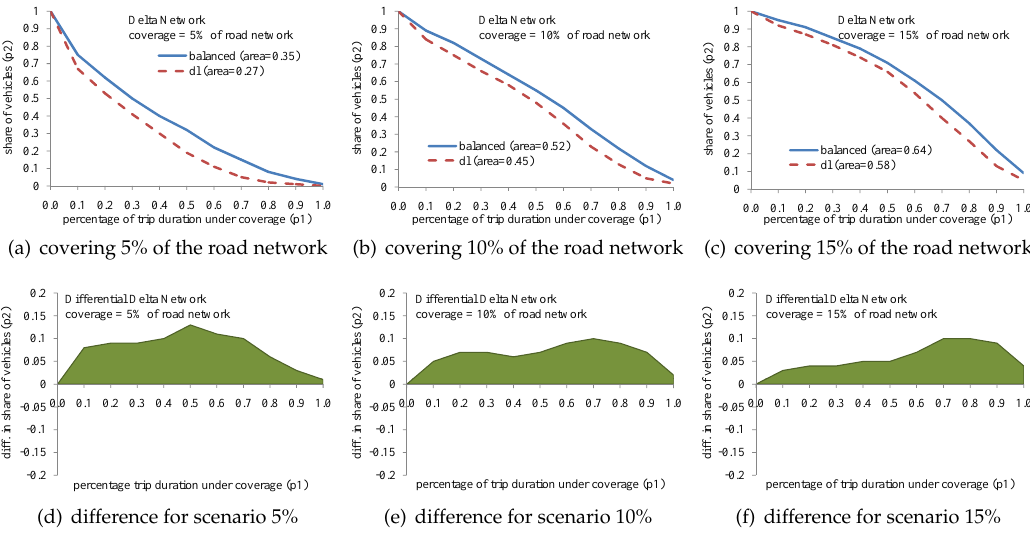
Figure 6. Delta Network: dl deploys roadside units at the most popular locations (red color), while balanced assumes an uniform distribution of weights (color blue). The y -axis indicates the share of vehicles ( ρ 2 ), while the x -axis indicates percentage of trip under coverage ( ρ 1 ). ( a – c ) Consider coverage ranging from 5% up to 15% of the road network. ( d – f ) Represent the difference “ balanced minus dl ”. Since the green area is positive, balanced is always providing more